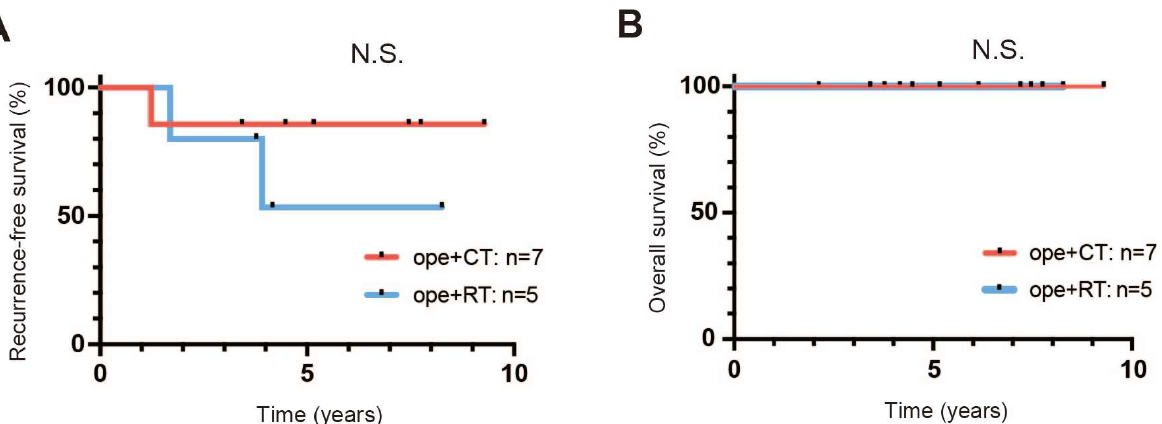
Figure 2. Prognosis of patients with (tumor and node) T1N1. ( A ) Recurrence-free survival (RFS). ( B ) Overall survival (OS). ope+CT, patients who underwent surgery and chemotherapy (neoadjuvant or adjuvant); ope+RT, patients who underwent surgery followed by radiotherapy (including concurrent chemoradiotherapy). N.S.: not significant. Survival curves were estimated by the Kaplan–Meier method and compared using the log-rank test.